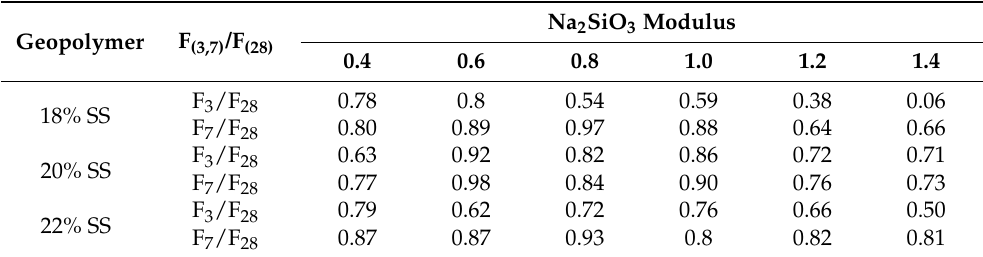
Table 8. The ratio of 3-day and 7-day flexural strength of different geopolymers to 28-day compres- sive